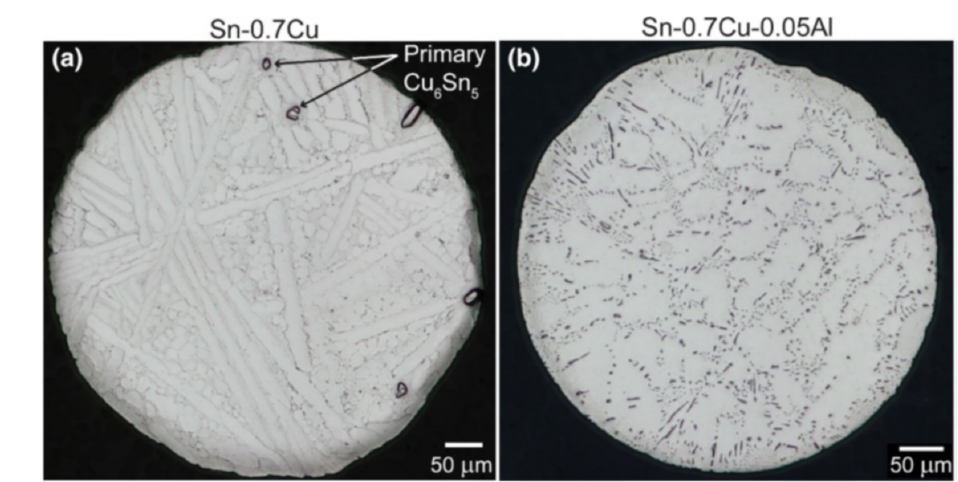
Figure 2. Microstructure images of ( a ) Sn-0.7Cu, ( b ) Sn-0.7Cu-0.05Al